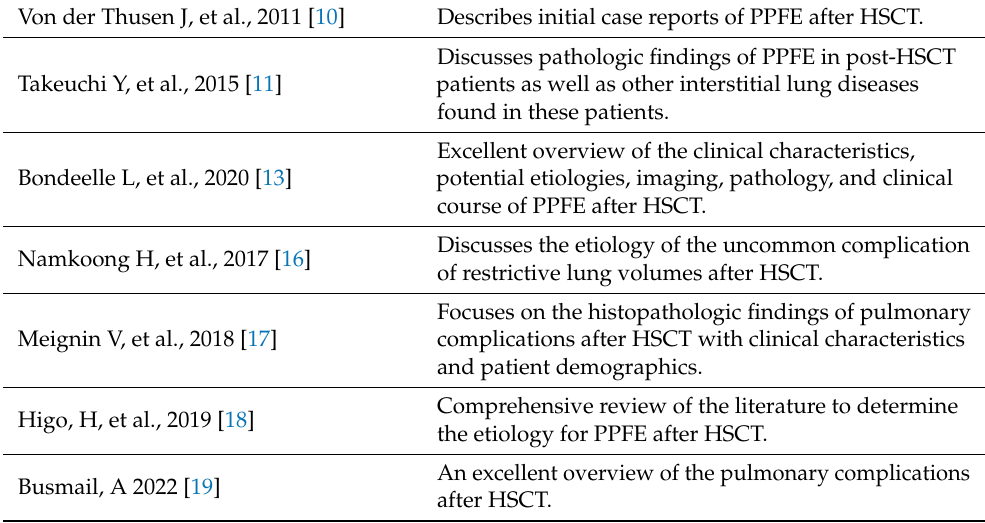
Table 1. Literature of PPFE after